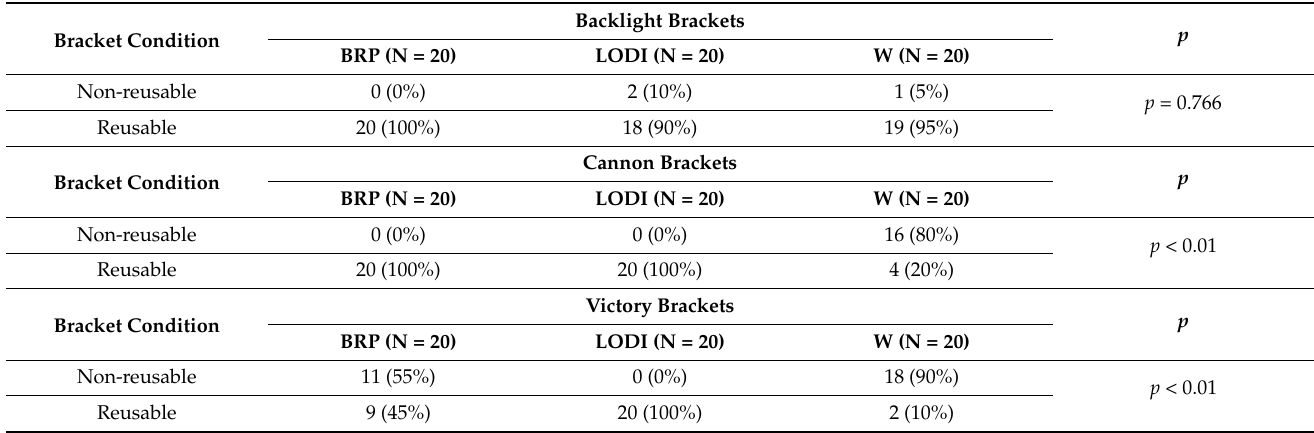
Table 6. Comparison of bracket